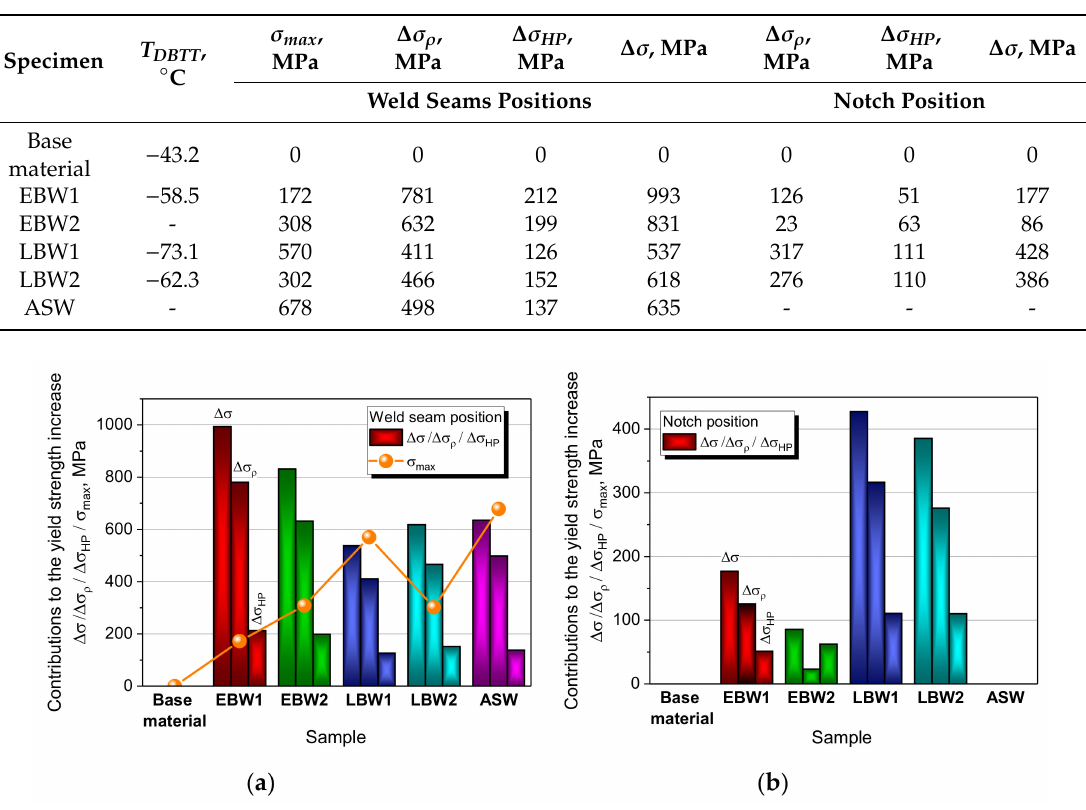
Figure 12. Contributions to the yield strength increase due to dislocation ∆ σ ρ and grain boundary ∆ σ HP strengthening, total yield strength increase seam centers ( a ) and at notch position ( b ).